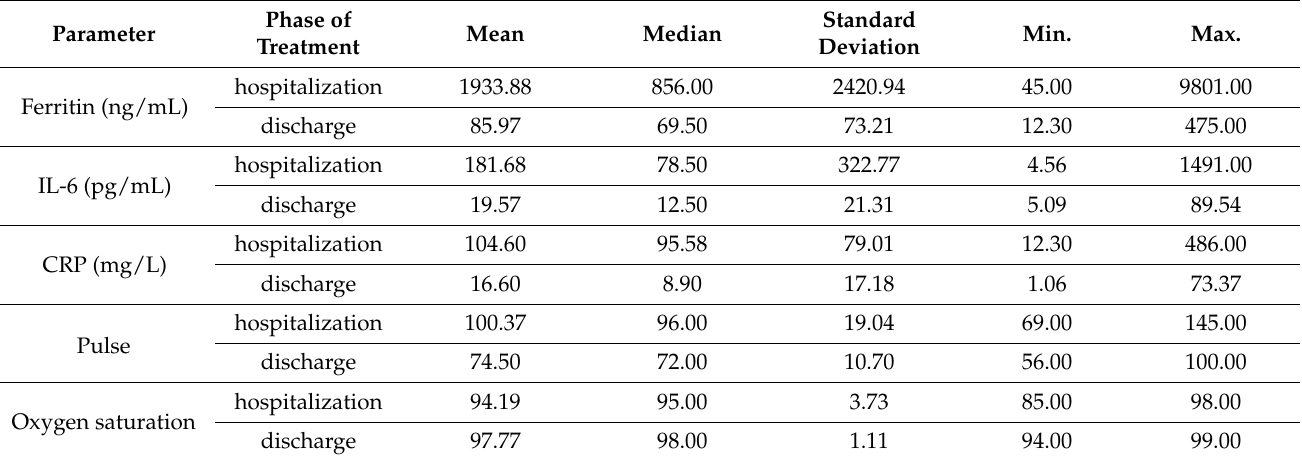
Table 2. Biological parameters of study participants.